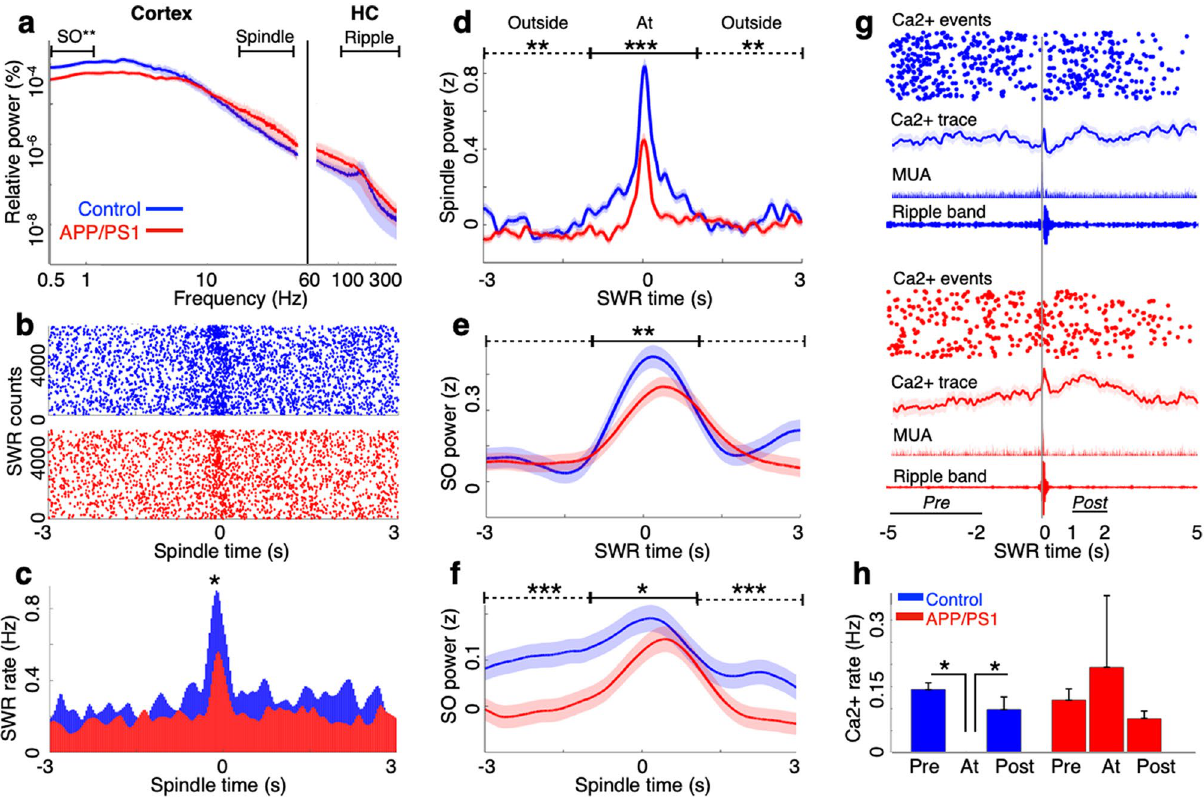
Figure 2. Aβ impairs cortical–hippocampal coordination and SWR modulation in slow wave sleep. ( a ) Cortical slow oscillation (SO) power in SWS was lower in APP/PS1 mice than in control mice, in contrast to comparable cortical spindle power and hippocampal ripple power. ( b ) Rasters and ( c ) peri-event time histograms (PETH) of SWRs around spindles in SWS showed reduced SWR-spindle co-occurrence in APP/PS1 mice compared to control mice; ( d ) spindle power was lower in APP/PS1 mice compared to control mice, at (solid line) and outside (dashed line) SWRs; ( e ) SO power was selectively reduced at SWRs in APP/PS1 compared to control mice; ( f ) SO power was lower in APP/PS1 compared to control mice, at and outside spindles. ( g ) SWR-triggered rasters of dynamic calcium events, averages of CA1 neuronal calcium traces, multi-unit activity (MUA) and ripple band of LFP in each genotype in SWS. ( h ) Across animals, SWR modulation of dynamic calcium activity observed in control mice was degraded in APP/PS1 mice. * p < 0.05; ** p < 0.01; *** p < 0.001, ANOVA with post-hoc comparisons, 2-sided t-tests. control n = 6 mice, n = 3486 SWR events, n = 2984 spindle events; APP/PS1 n = 6 mice, n = 3214 SWR events, n = 2523 spindle events. Data in ( a ) and ( d, e, f ) are smoothed with a Gaussian window (σ = 200 ms and σ = 300 ms, respectively) for display purposes. Data are represented as mean ±